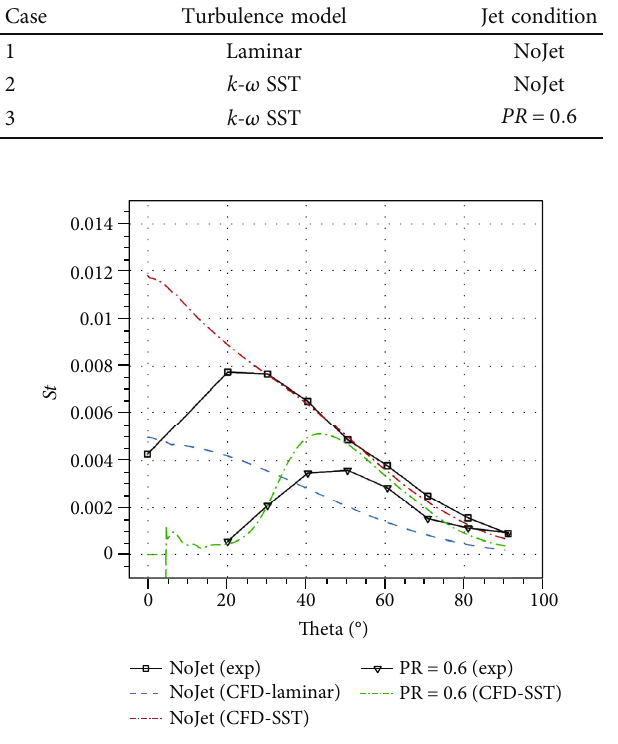
Figure 7: Validation results.